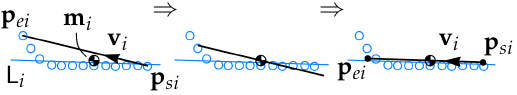
Figure 12. Alignment of segment i to the point set S i . First the segment is translated to the mass center m i of S i , then it is rotated to match the direction of L i .